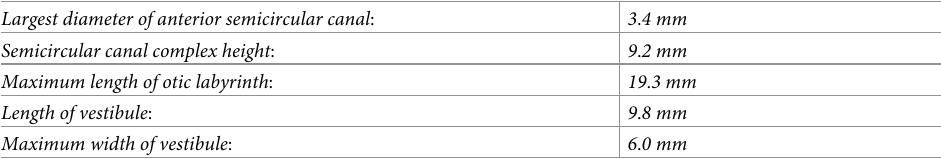
Table 3. Measurements of the otic labyrinth in